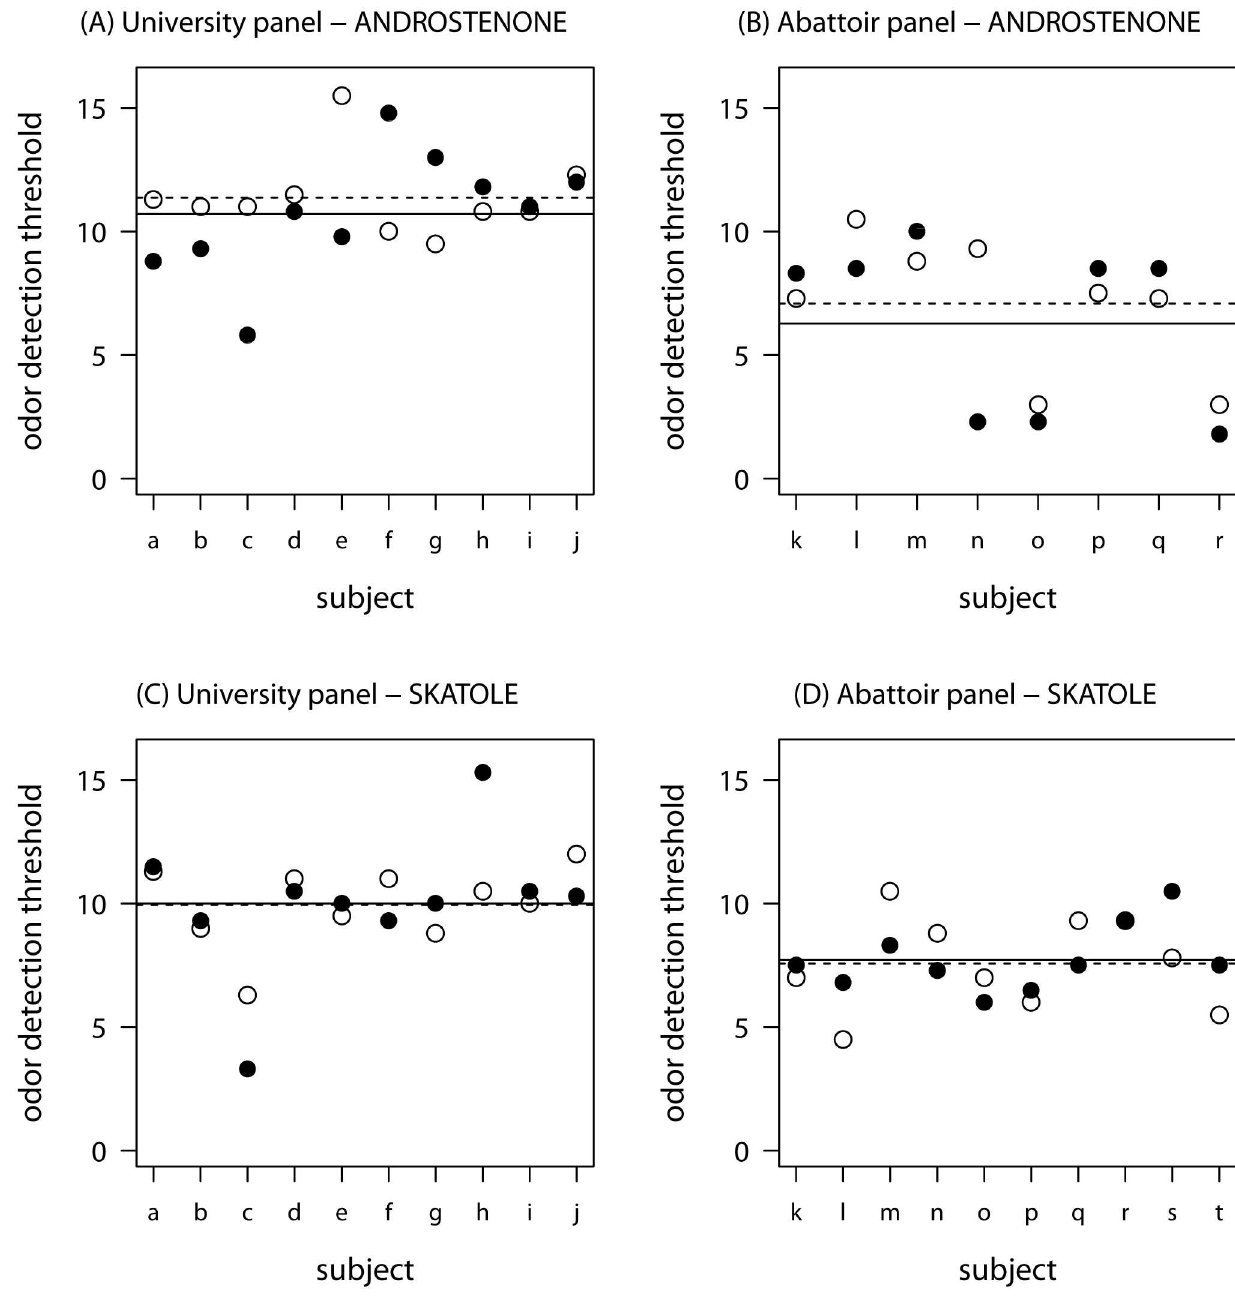
Fig 2. Odor detection thresholds for androstenone and skatole of the university panel (left) and the abattoir panel (right) under noise ( ● ) and silent conditions ( (cid:14) ) including the panel averagefor the silent (- - -) and noisy condition ( ── ). The scores in the threshold test can range between-3 and 20 and they represent a series of binarydilutionsof the respective odorant; dilutionstep -3 corresponds to 8 mMol. That is, a higherdilutionstep indicatesa lower detectionthreshold,i.e. highersensitivity. Two assessors of the abattoirpanel were obviously insensitive towards androstenoneand thus excludedfrom this analysis. Abattoir noise (70 dB) was appliedusing headphones.